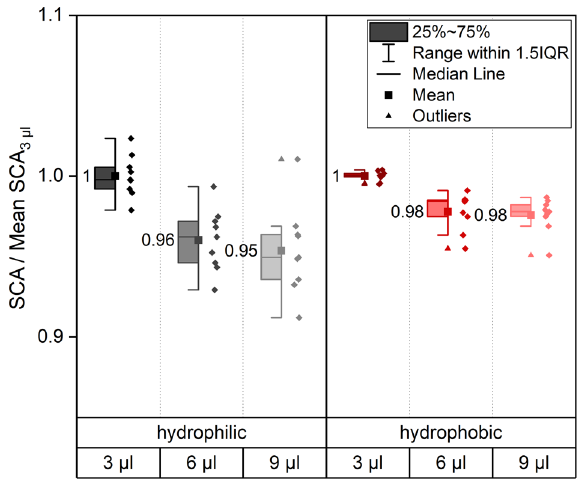
Figure 7. SCA measurements with different droplet volumes. For direct comparison of the influence of the droplet volume contact angles on the same sample were measured with 3 µl, 6 µl and 9 µl droplets. In total three samples were analyzed per wetting condition with three droplets of each volume per sample. The reference data for normalization is “3 µl”. For both wetting types a separate normalization was carried